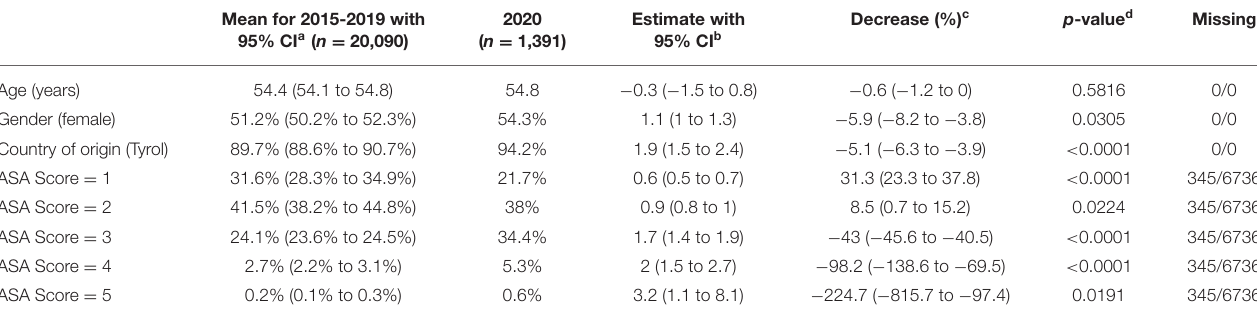
TABLE 1 | Presented are age, gender, comorbidities, and country of origin of patients during the observation period in 2020 compared to the same period in